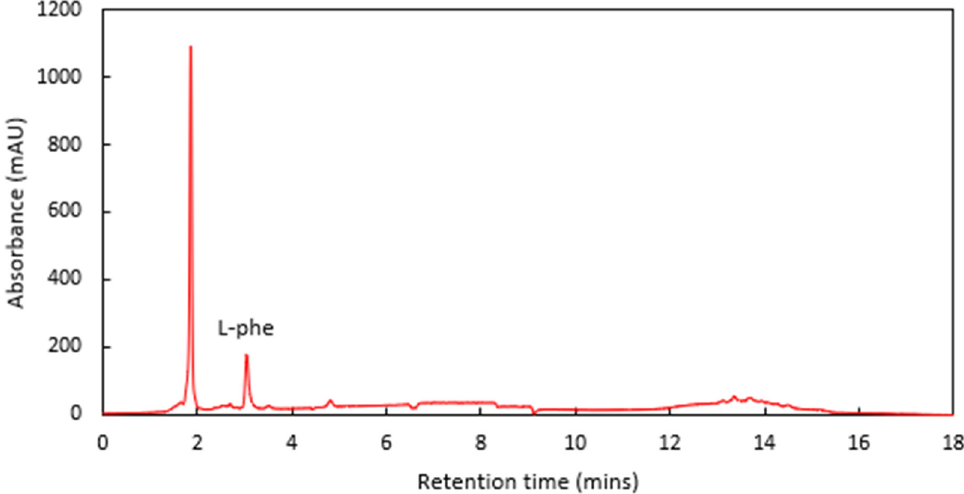
Figure 3. HPLC chromatogram output (at 260 nm) of a cider sample spiked with L-phenylalanine (4.0 g L − 1 ), showing the elution of L-phenylalanine at 3.049 min. A linear increase to 100% MeOH was used to elute all unwanted compounds from the column between 8–18 min.